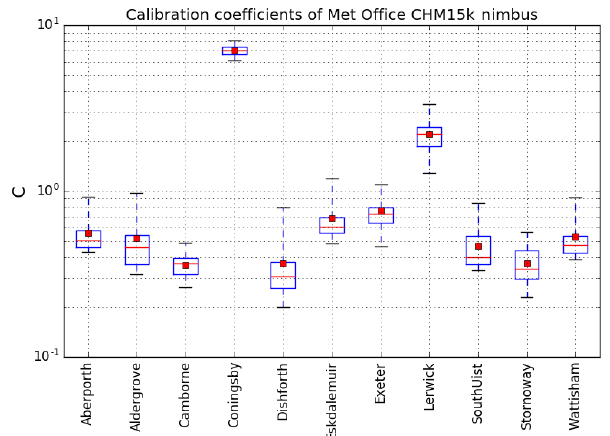
Figure 13. Calibration coefficient for each of the CHM15k Nim- bus ceilometers in the UK Met Office network: 3 months of data (January–March 2016) have been used for each instrument. The number of suitable calibration profiles will be dependent on occur- rences of cloud and therefore will vary for each instrument. The box outline represents 50% of the calibration profiles and the whiskers extend to include 95% of the profiles (outliers have been excluded from plot). The horizontal red line in the box shows the median calibration coefficient and the filled box shows the